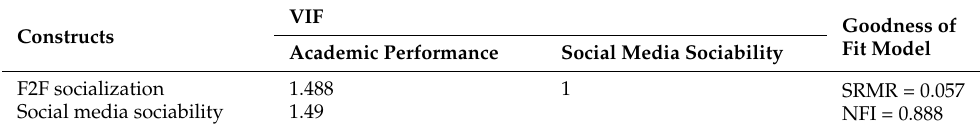
Table 8. The VIF and model’s goodness of fit.